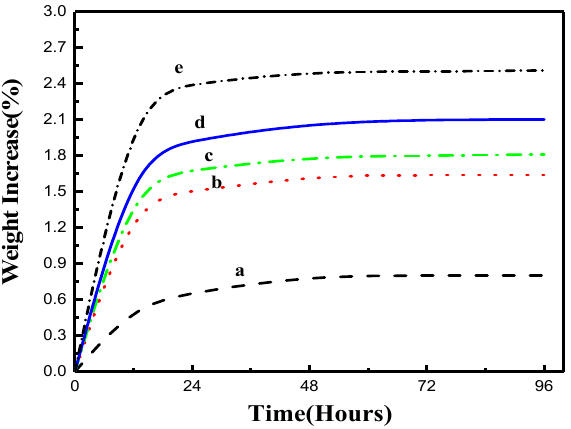
Figure 5. ( a ) Water absorption rate of virgin PLA; ( b ) PLA/PEG; ( c ) PLA/PEG/CNF 1 wt.%; ( d ) PLA/PEG/CNF 2.5 wt.%; ( e ) PLA/PEG/CNF 5 wt.%.